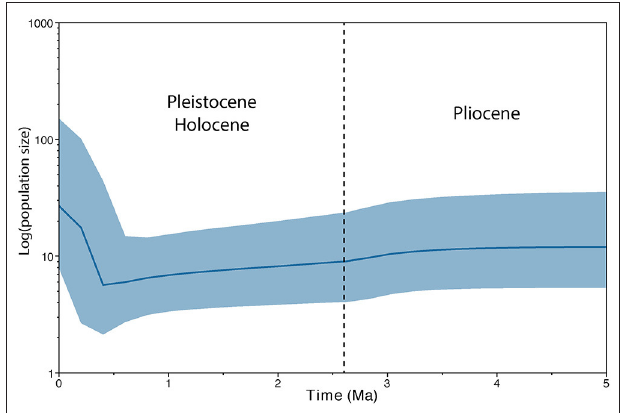
FIGURE 4 | Bayesian skyline plot inferring the effective population size of Bufo stejnegeri